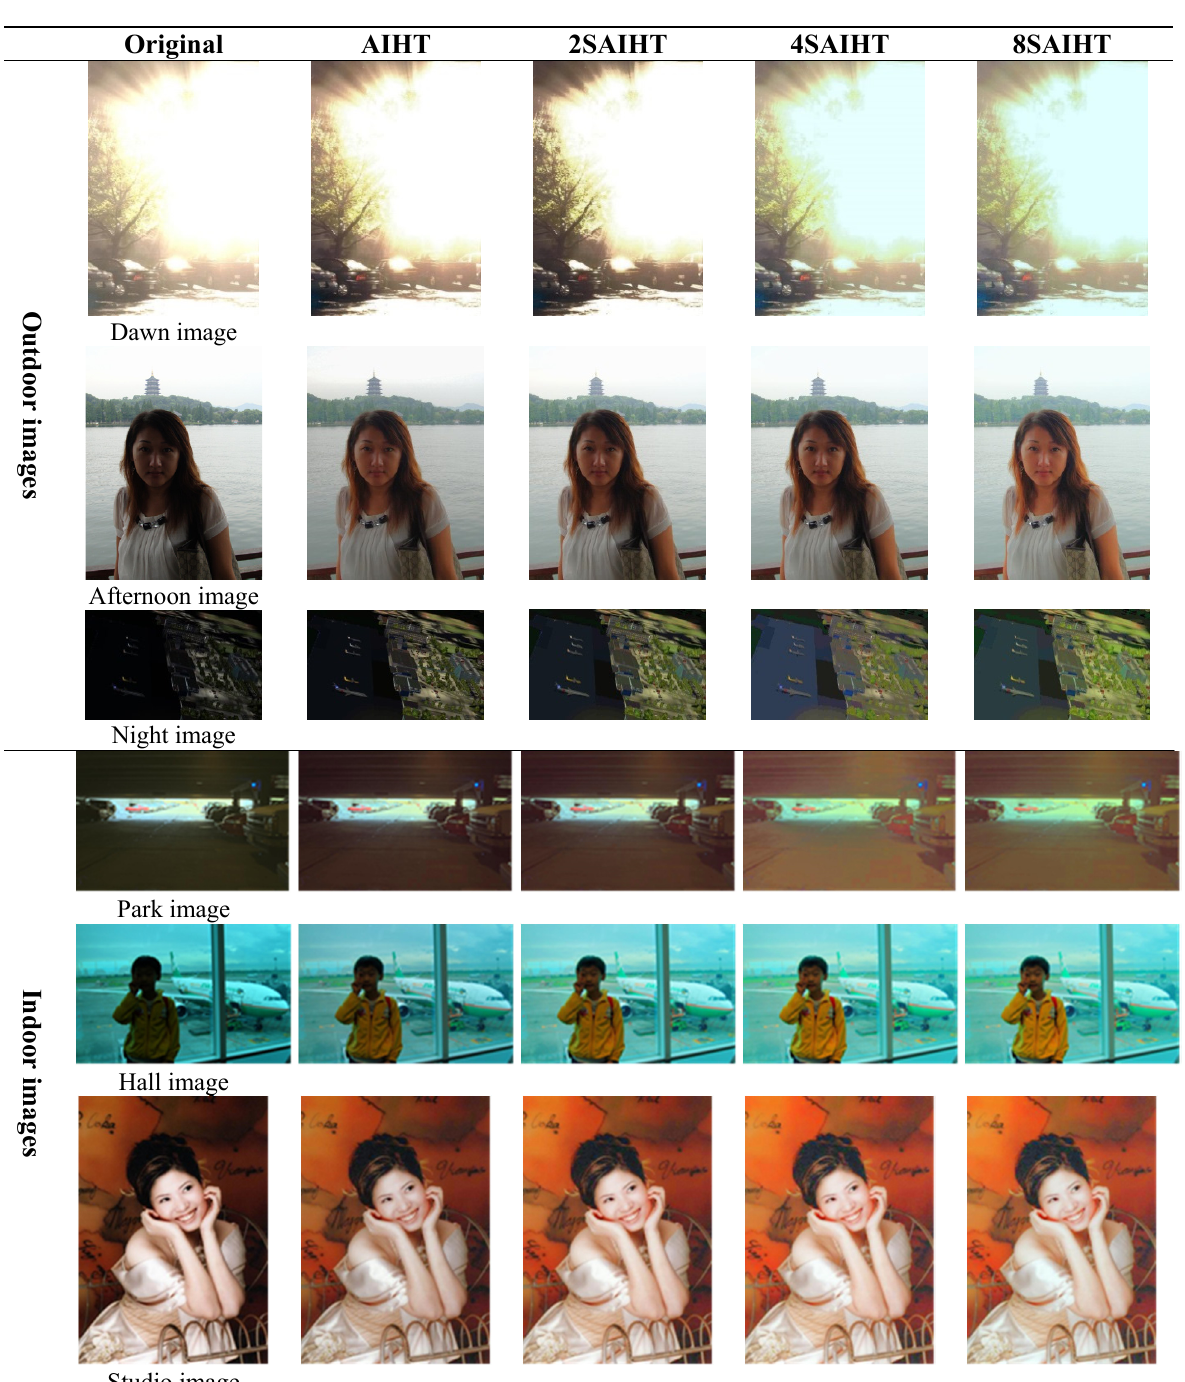
Figure 3. Various types of bad contrast images illustrating the difference between contrast enhancement by Contrast Limited Adaptive Histogram Equalization, Adaptive Inverse Hyperbolic Tangent (AIHT) and MSAIHT (including 2SAIHT, 4SAIHT and 8SAIHT). Original AIHT